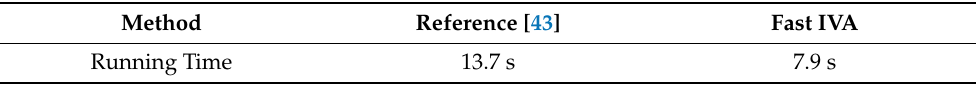
Table 6. The running time required for the algorithm to